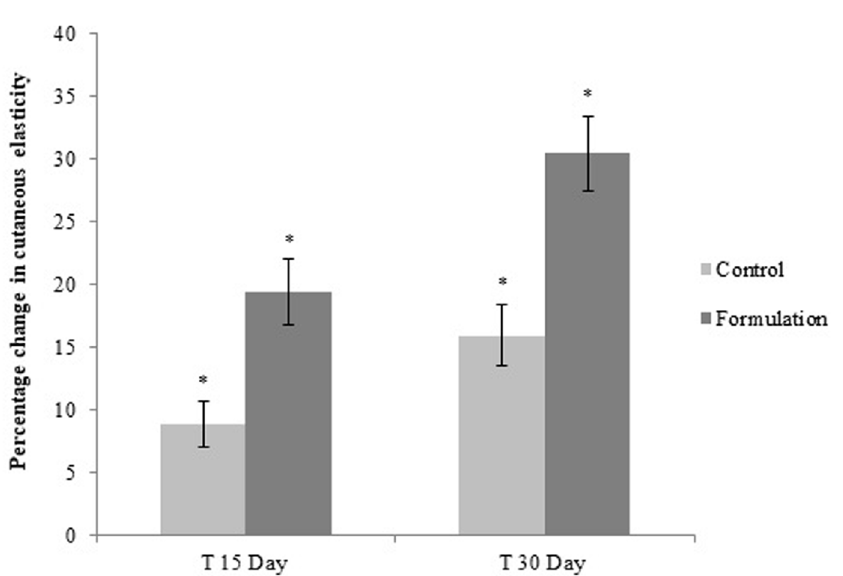
FIGURE 5 - Percentage increase in cutaneous elasticity for the control (hydrogel without the Gac extract) and the formulation containing the Gac extract after the 15- and 30-day application period compared to values before treatment (mean ± SD). * Significantly different from day zero of treatment ( p ≤